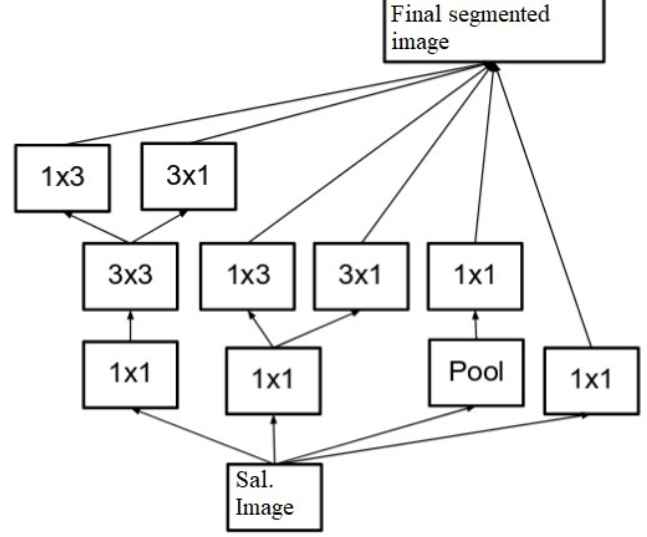
Figure 5. Design of the Inception Model.